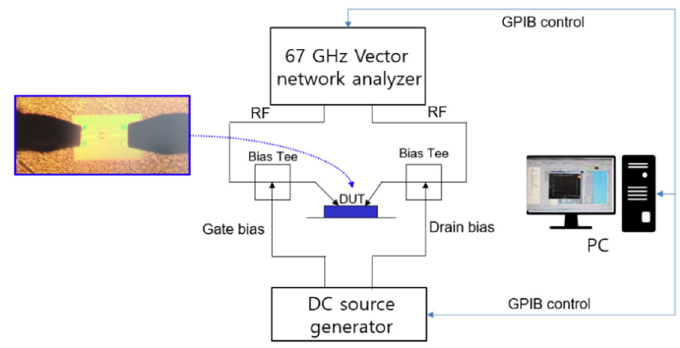
Figure 9. Block diagram of a 67 GHz S-parameter measurement setup.